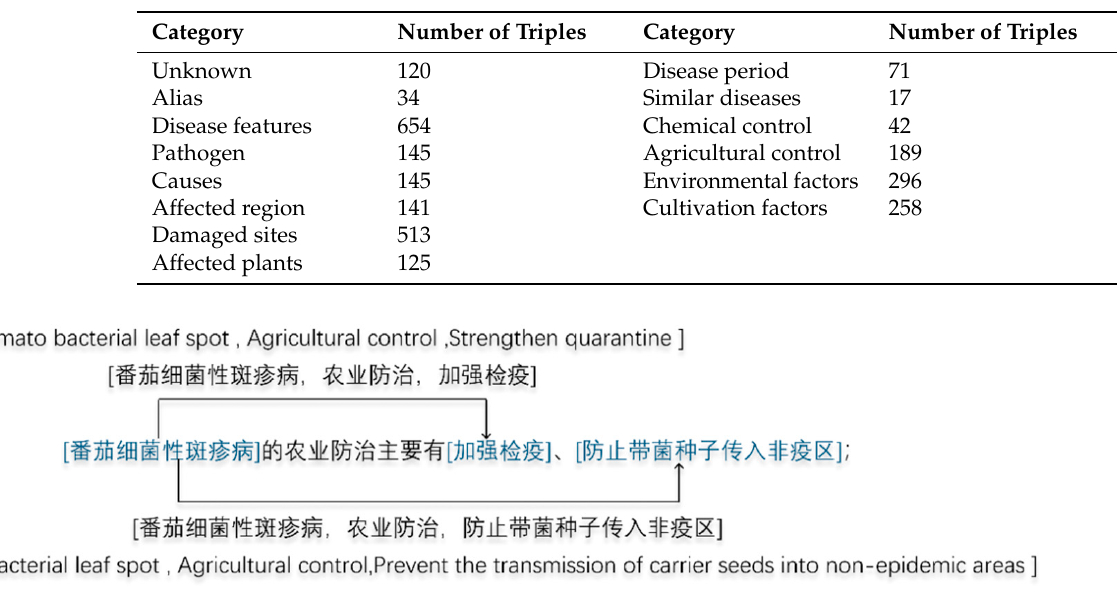
Figure 7. An example of relation labeling. Example “ 番茄细菌性斑疹病的农业防治方法主要有加强检疫、防止带菌种子传入非疫区 ” (this means that the agricultural prevention and control methods of tomato bacterial leaf spot mainly include strengthening quarantine and preventing the introduction of bacterial seeds into non-epidemic areas). Table 2. Relation categories.